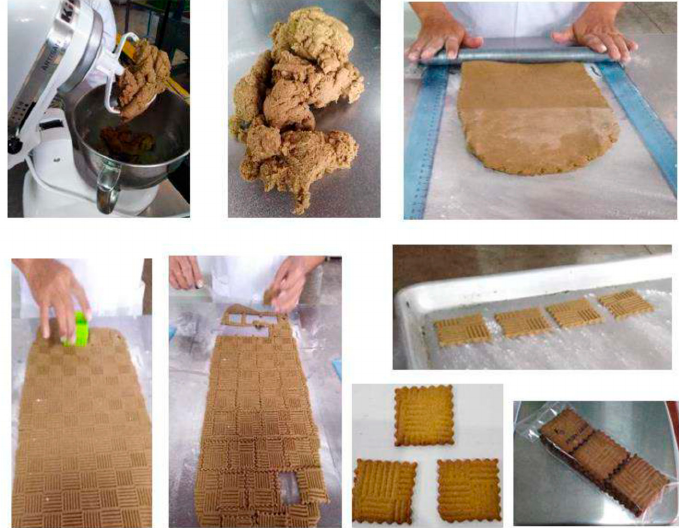
Figure 1. Biscuit elaboration process. From left to right: kneading; biscuit dough; dough sheeted with a rolling pin; biscuits were cut and placed in an oven tray; biscuits baked at 150 °C for 15 min; and wrapped in polypropylene plastic bags.